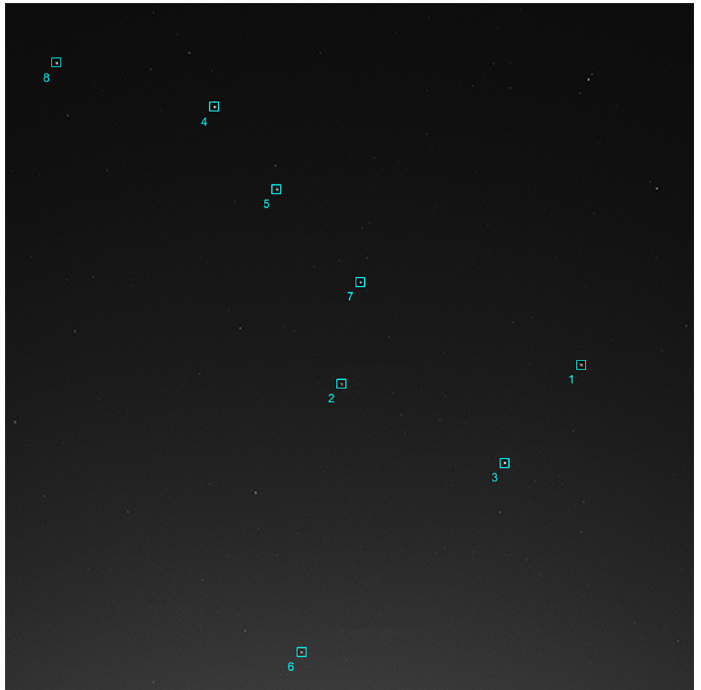
Figure 11. Ursa Major constellation stars localization performed by the BOSS algorithm. Names and visual magnitudes of the segmented objects have been reported in Table 3. Table 3. IDs, names and visual magnitudes of the segmented objects in Figure 11.